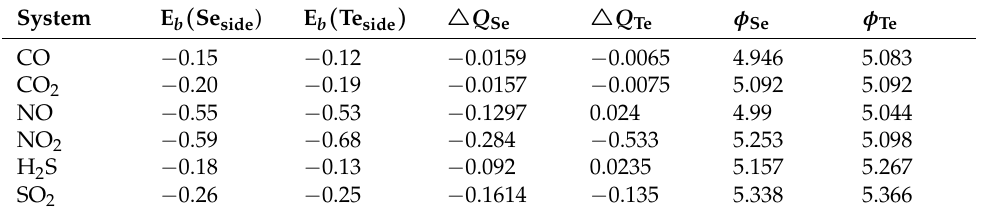
Table 1. Calculated binding energy ( E b ) when gas molecules absorbed on the surface of the Janus NbSeTe monolayer, charge transfer ( (cid:52) Q ) between gas molecules and Janus NbSeTe sheet, and work function ( φ ) variation during the gas molecules absorption process on the Se- and Te-side.